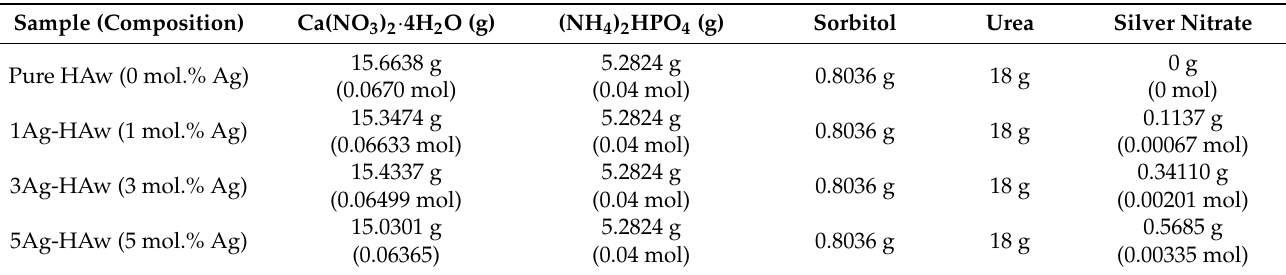
Table 1. The solutions used for the synthesis of